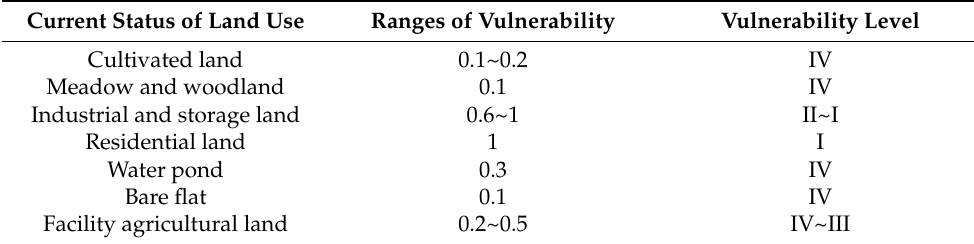
Table 3. Vulnerability of different land use status [22].